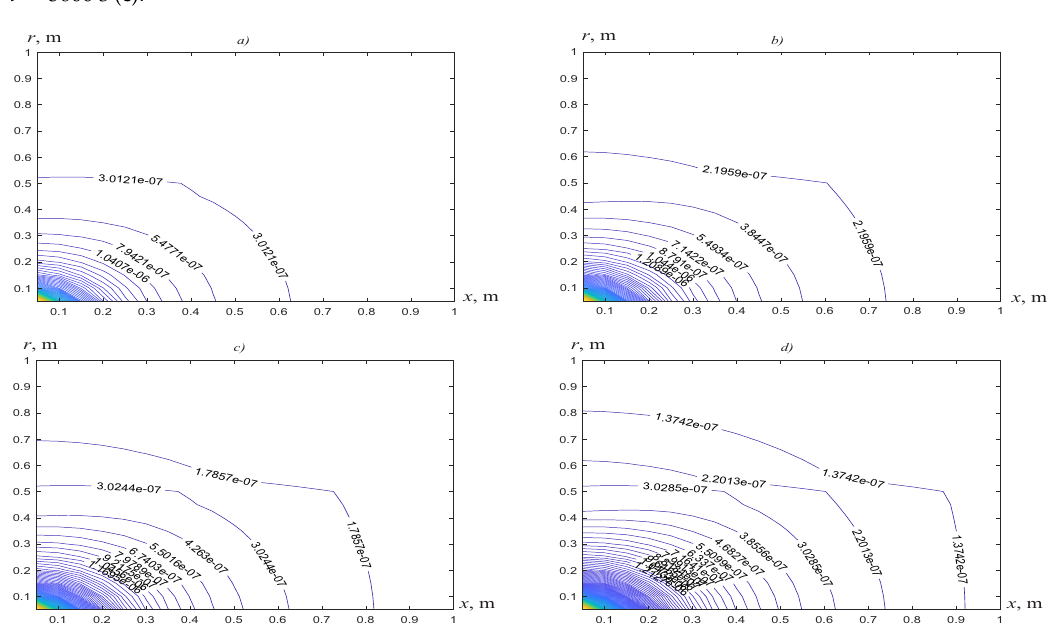
Figure 3. Surfaces of P at γ 1 = 1, γ ∗ D 1 r = 5 · 10 − 5 m 2 γ 1 /s, D 2 x = 10 − 5 m γ ∗ 2 /s, D 2 r = 10 − 5 m 2 γ 2 /s, t = 900 s ( a ); t = 1800 s ( b ); t = 3600 s ( c ).